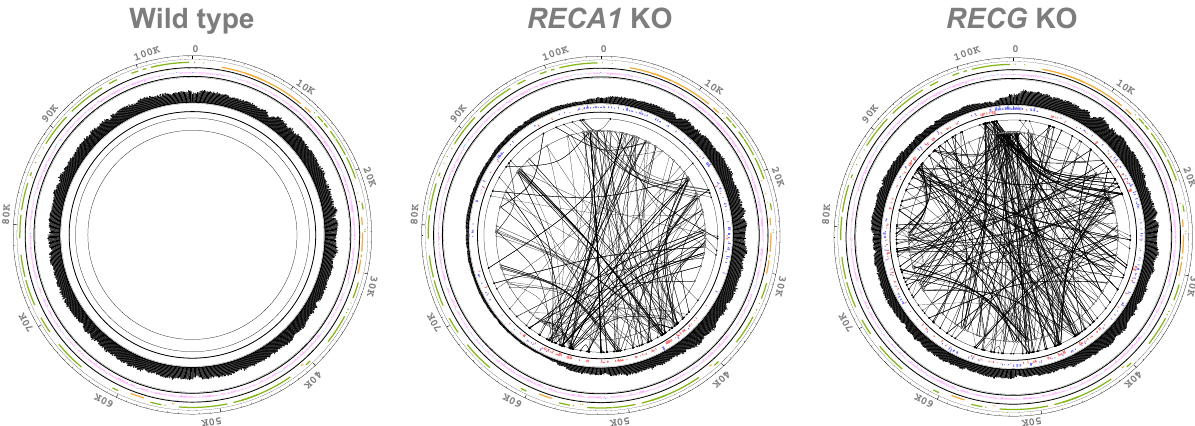
Fig. 6 Links of junction reads in mitochondrial DNA. Rearrangements identi fi ed by junction reads are shown as links on the mtDNA map along with mapping depth. Detailed explanation of the tracks is found in Supplementary Fig. 8.